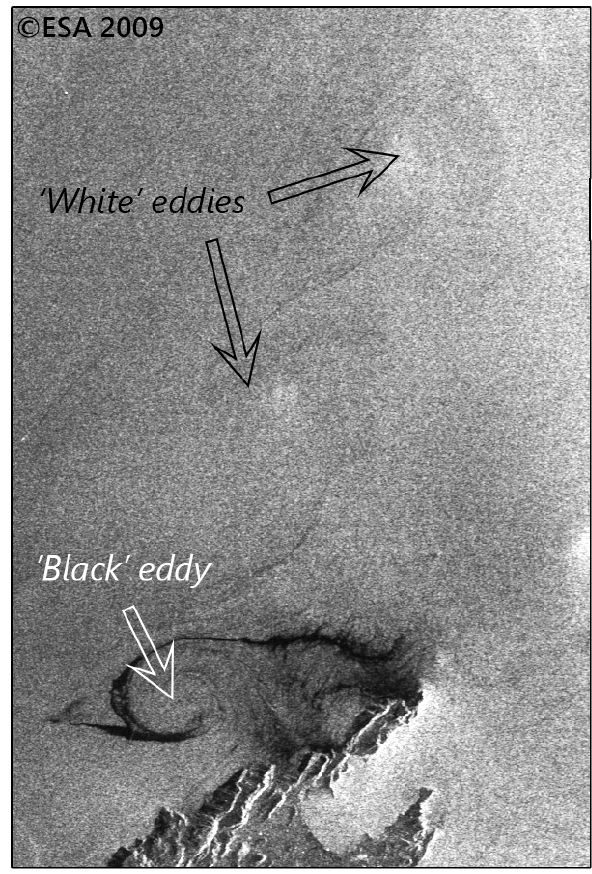
Figure 14. A chain of two ‘white’ eddies and one ‘black’ eddy observed to the north from the island Mallorca The spatial distribution of ‘black’ and ‘white’ eddies detected in Envisat ASAR images in 2009-2011 is illustrated by Figure 15. ‘Black’ eddies were found practically everywhere in the Western Mediterranean except for the area of the Sicily Channel and the central part of the Tyrrhenian Sea (Figure 15, upper panel). Decreased density of eddies is also observed in the region to the south-east from the Gulf of Lion, where strong wind-induced mixing frequently occurs.